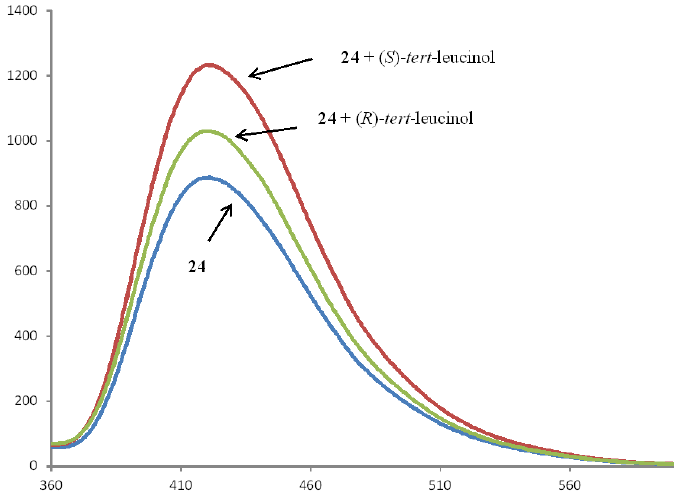
Figure 11. Fluorescence spectra of Compound 24 in the presence of ( R )- and ( S )-enantiomers of tert -leucinol (1000 equiv.).